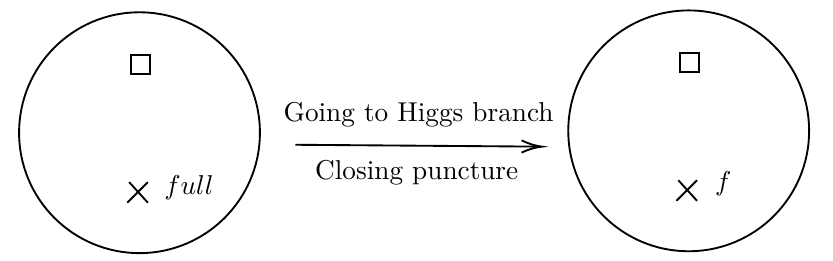
Figure 2 . Left: a 4d theory defined by an irregular singularity and a full regular singularity (the nilpotent orbit f is trivial). Right: a 4d theory defined by an irregular singularity and a regular singularity labeled by f . Going to Higgs branch of this theory is equivalent to closing off the regular puncture, i.e. change the type of regular